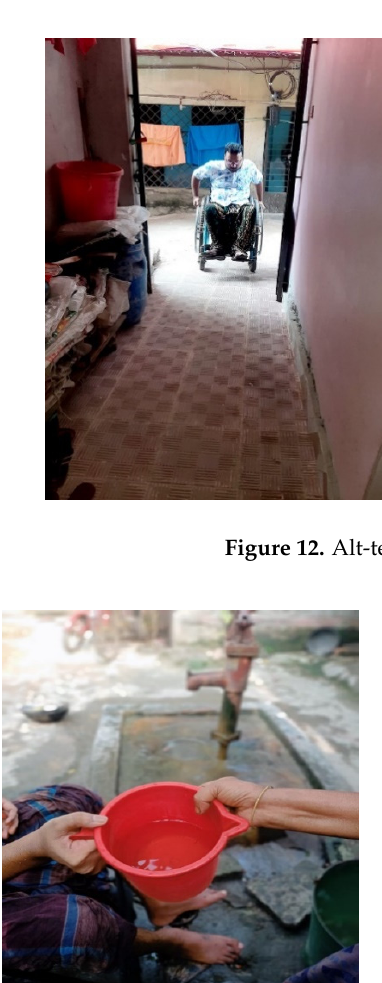
13 of 20 Figure 11. Alt-text: Young woman wearing a blue face mask. Ongoing mobility challenges were captured across Bangladesh and Liberia; wheelchair users are unable to access roads during the rainy seasons, or access banks. Many co-researchers highlighted how inaccessibility creates further distance and